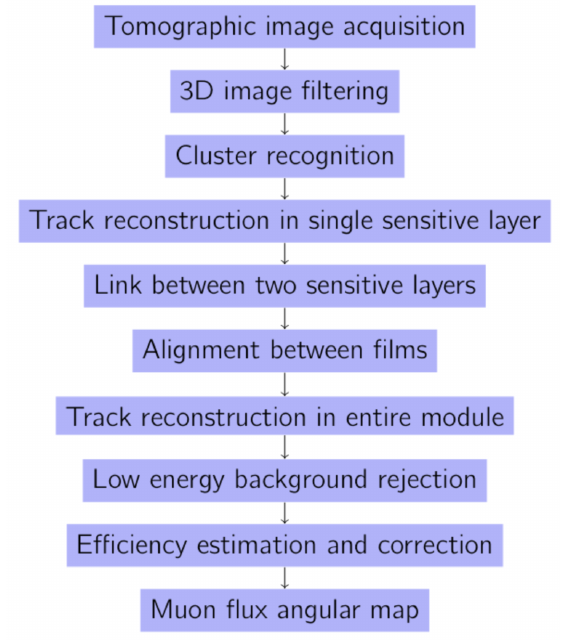
Figure 7. Procedure for the muon flux